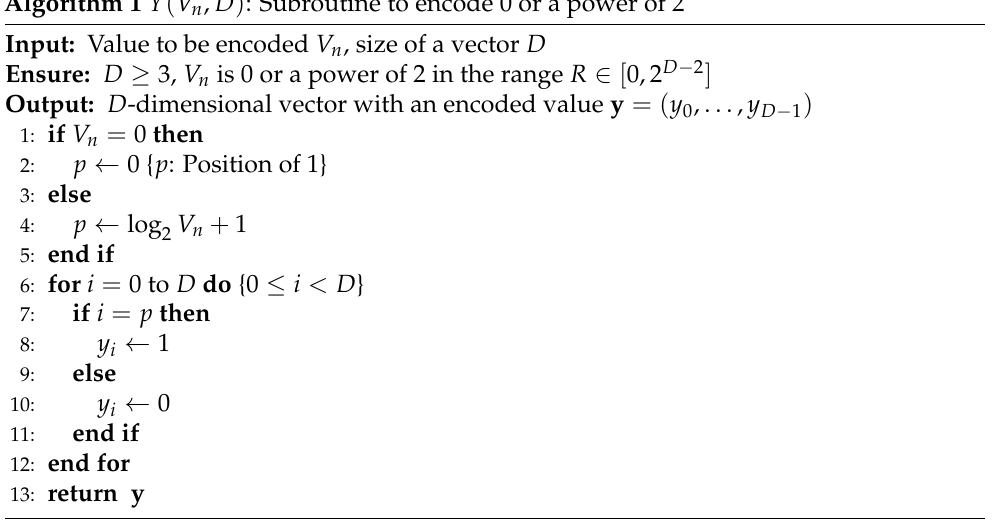
Algorithm 1 Y ( V n , D ) : Subroutine to encode 0 or a power of 2